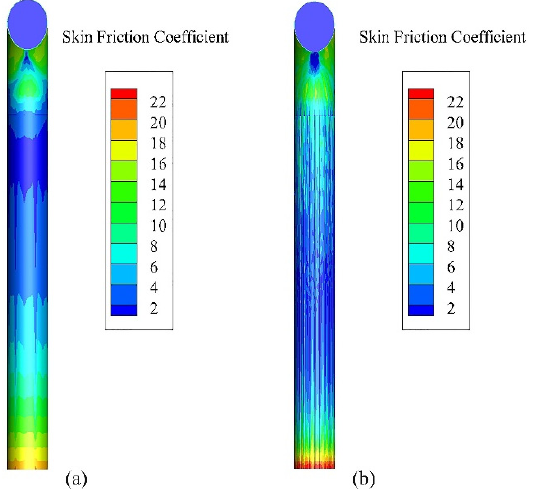
Figure 15. Surface friction coefficient nephogram: ( a ) prototype and ( b ) bionic tailpipe. Table 4. The surface friction coefficient of the tailpipe wall at different inlet velocities. Figure 14. Vertical flow direction section velocity amplitude nephogram: ( a ) prototype and ( b ) bionic tailpipe.